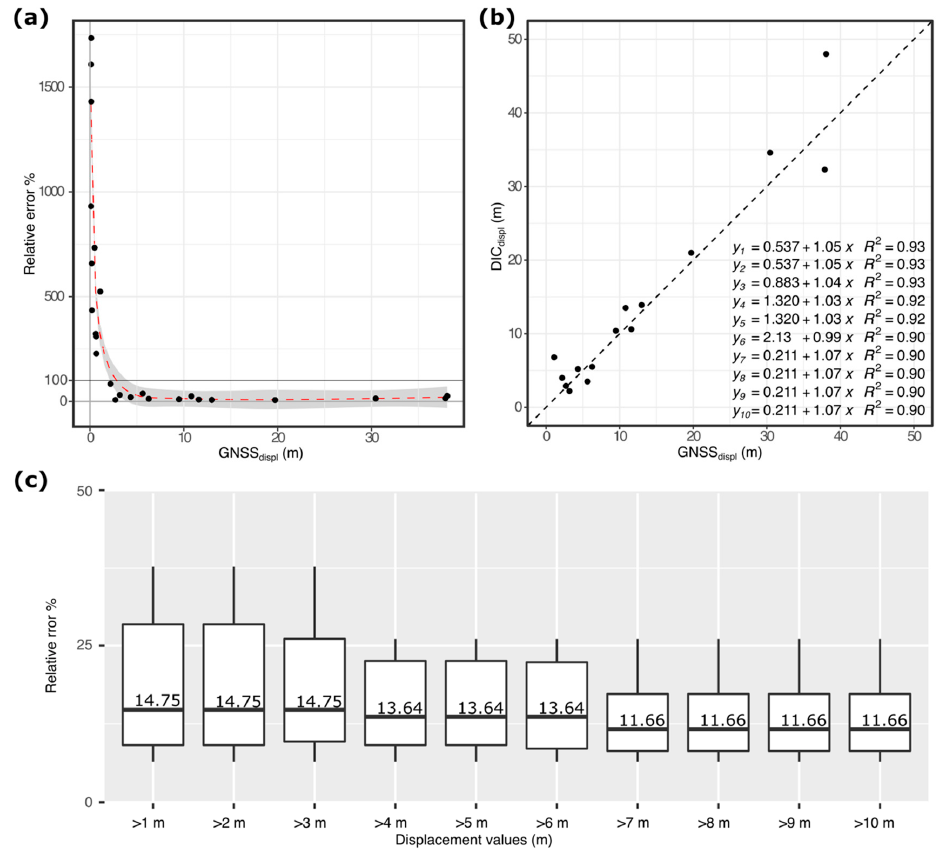
Figure 9. Error analysis: ( a ) relative error of DIC displ as a function of GNSS displ , where the grey area is the 95% confidence band for the red dashed regression curve; ( b ) DIC displ vs. GNSS displ : y 1 to y 10 are the equations resulting from linear fit of points belonging to thresholds from 1 to 10 m and the respective coe ffi cient of determination. Displacements smaller than 1 m are excluded; ( c ) Percentage error according to displacement threshold classes. Boxplots ranges: extremes of the boxes are the 1st and 3rd quartile (Q 1 and Q 2 ). The black lines depict median values, the lower whisker is “Q 1 -1.5 × IQR” and the upper whisker is “Q 2 -1.5 × IQR” (where IQR stands for “interquartile range” and is the di ff erence between Q 2 and Q 1